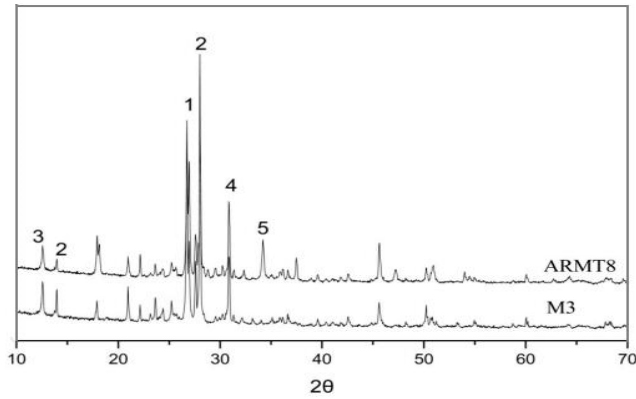
Figure 15. XRD results of the sample M3 (Table 2) and sample ARMT8 (Table 3) (1 quartz, 2 albite, 3 chlorite, 4 dolomite, 5 biotite).